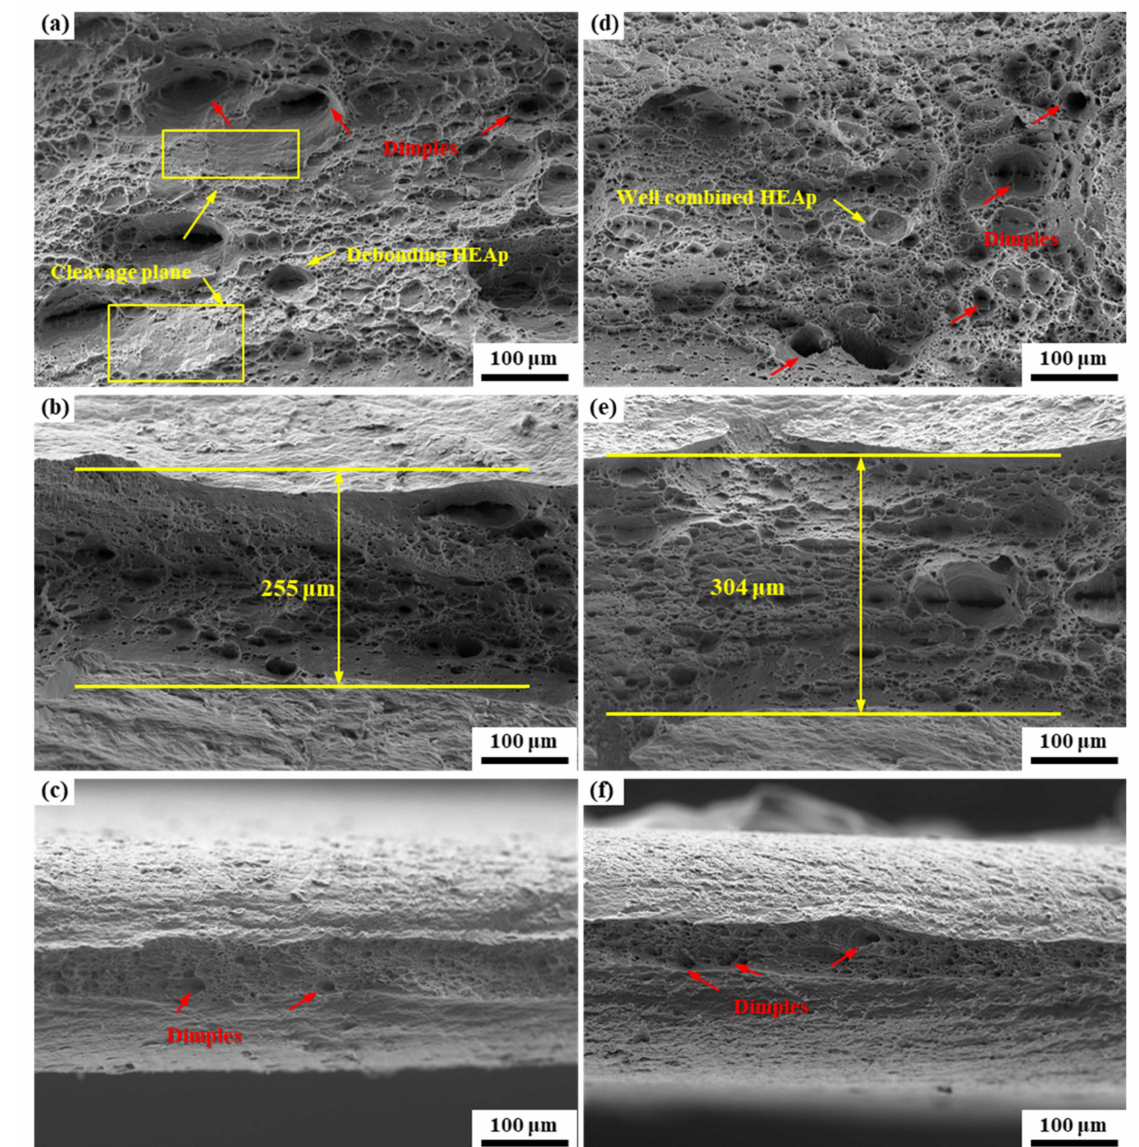
Figure 6. SEM images of RTR 1.5 wt% HEAp/AMCs at ( a ) 30%, ( b ) 60%, and ( c ) 90%. CR 1.5 wt% HEAp/AMCs at ( d ) 30%, ( e ) 60%, and ( f ) 90% rolling reduction-ratios fracture